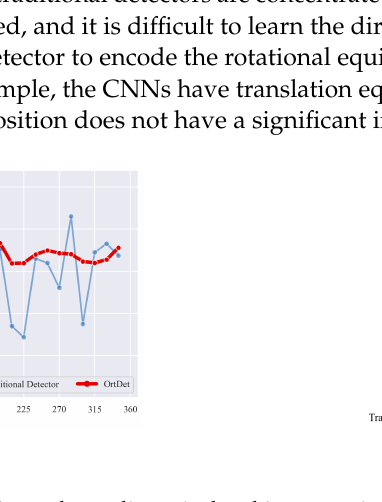
Figure 1. ( a ) The horizontal coordinate is the objects rotation angle in the validation set, the vertical coordinate is the AP, the red curve is our detector OrtDet, and the blue curve is the traditional detector. ( b ) Illustration of our method. The orange arrow represents the feature heat map, the blue arrow represents the rotation operation. Traditional detectors have difficulty in learning the orientation information of the objects, and their extraction features are focused on the center of the objects regardless of the rotation. Our OrtDet learned the orientation information of the object